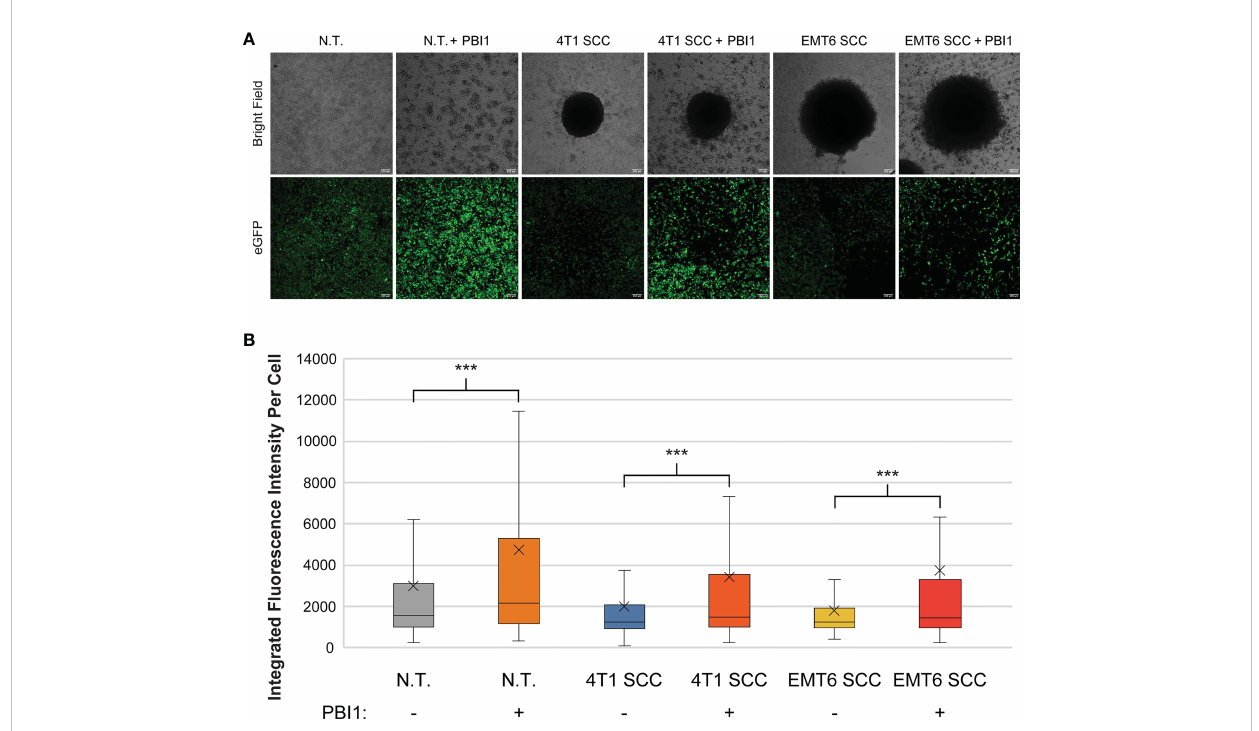
FIGURE 5 Re-polarization of RAW:iNos-eGFP macrophages using a small molecule in spheroid co-culture (SCC) models. (A) Confocal microscopy images of RAW:iNos-eGFP cells co-cultured with 4T1 or EMT6 spheroids, with (+) or without (-) PBI1 treatment. In spheroid co-culture samples, the black area in the respective images is the spheroid itself. Treatment with PBI1 is shown to enhance reporter fl uorescence across all treatments, including in SCC models. Scale bars on confocal images represent 100 µm. Images of additional spheroids are shown in Figure S6. (B) Student T-test was used for statistical analysis versus PBI1-treated groups (p<0.001 = ***). N.T. (-): n = 2991; N.T. (+): n = 1536; 4T1 SCC (-): n = 703; 4T1 SCC (+): n = 539; EMT6 SCC (-): n = 572; EMT6 SCC (+): n = 276. The “ x ” in the box represents the mean; the bottom and top lines of the box represent the median of the bottom half (1st quartile) and median of the top half (3rd quartile), respectively; the line in the middle of the box represents the median; the whiskers extend from the ends of the box to the minimum value and maximum value. N.T.,